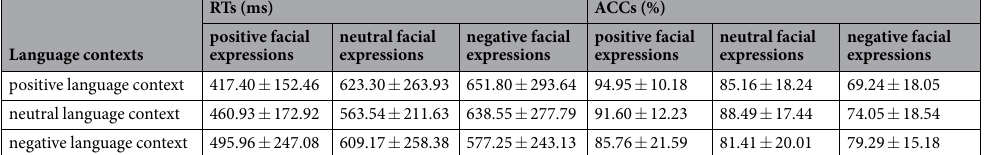
Table 1. RTs and ACCs for the judgment of facial expressions in different language contexts ( M ± SD